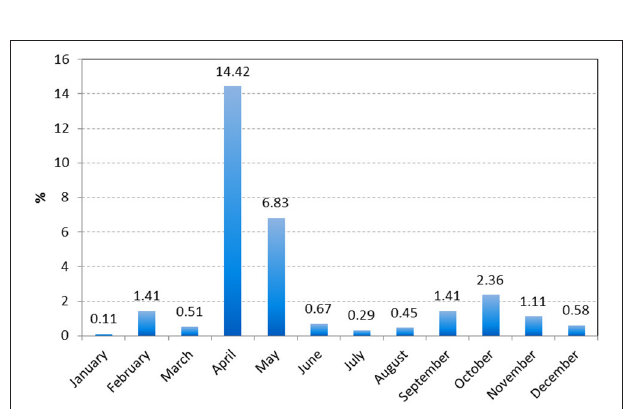
FIGURE 6 | Reduction of resuspension emissions due to precipitation